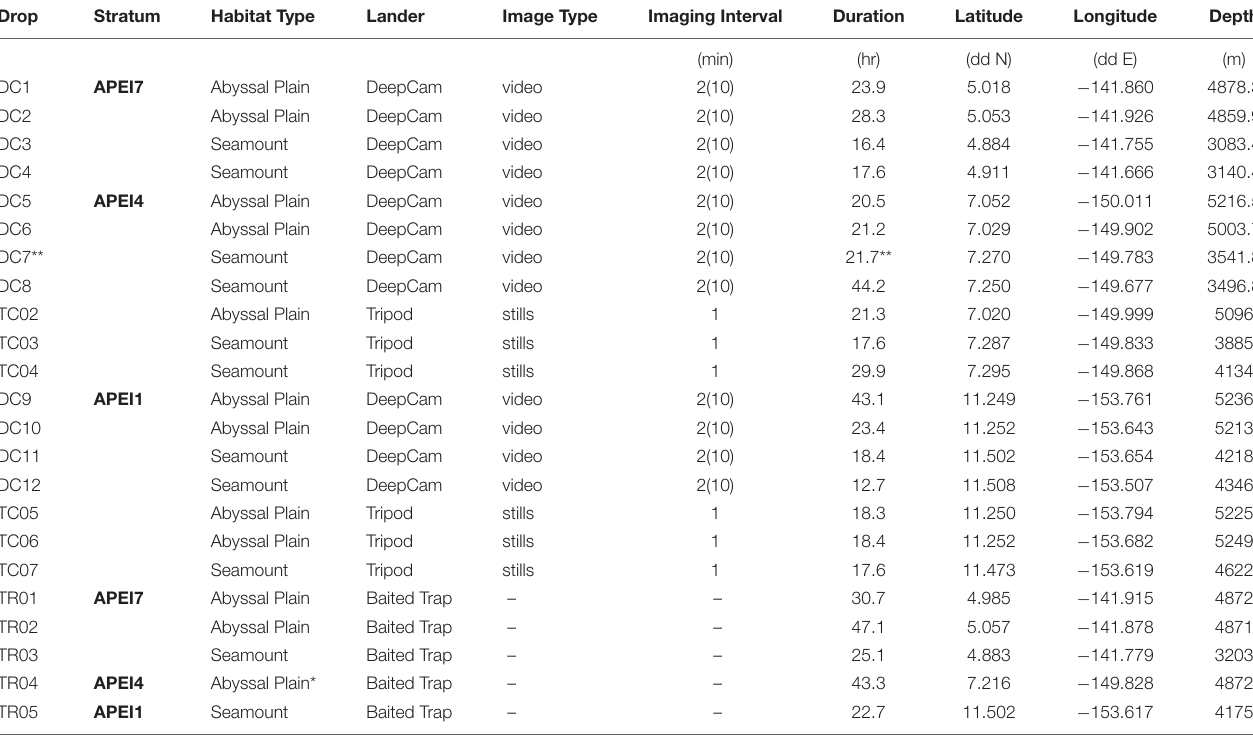
TABLE 1 | Metadata and deployment information for all lander